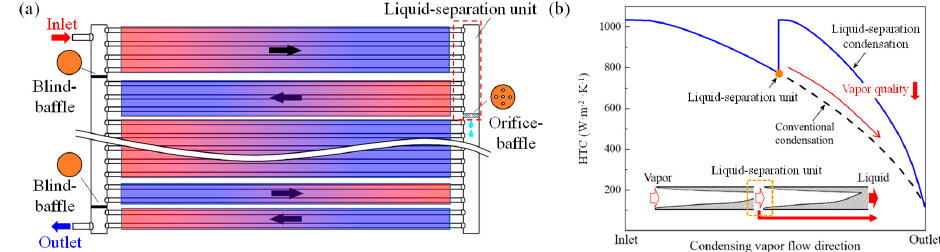
Figure 1. ( a ) Scheme of LSC; ( b ) HTC enhancement in LSC, modified from [2].